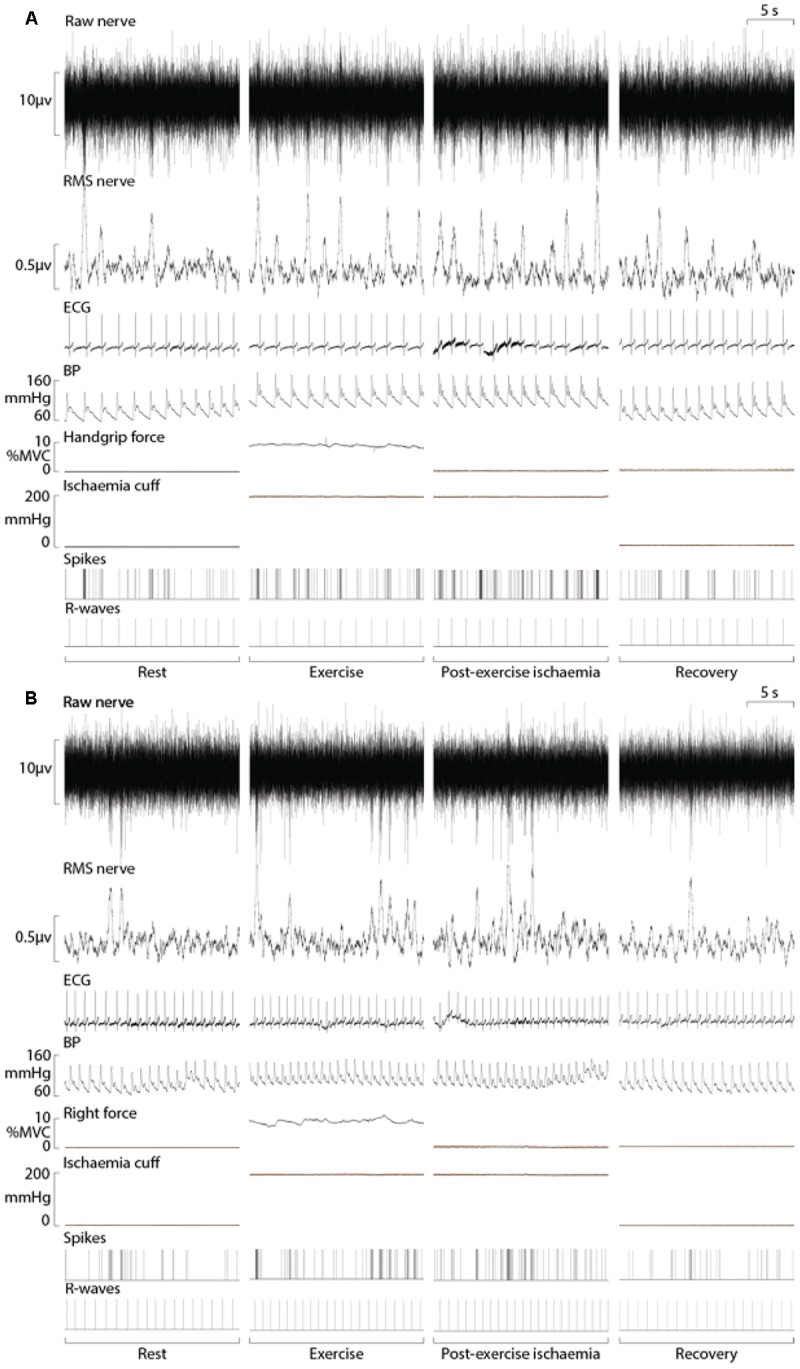
Experimental records from one subject during ischaemic handgrip (A) and ankle dorsiflexion (B) with a period of post-exercise ischaemia. Analysis of MSNA involved measuring the negative-going sympathetic spikes of the raw nerve signal.